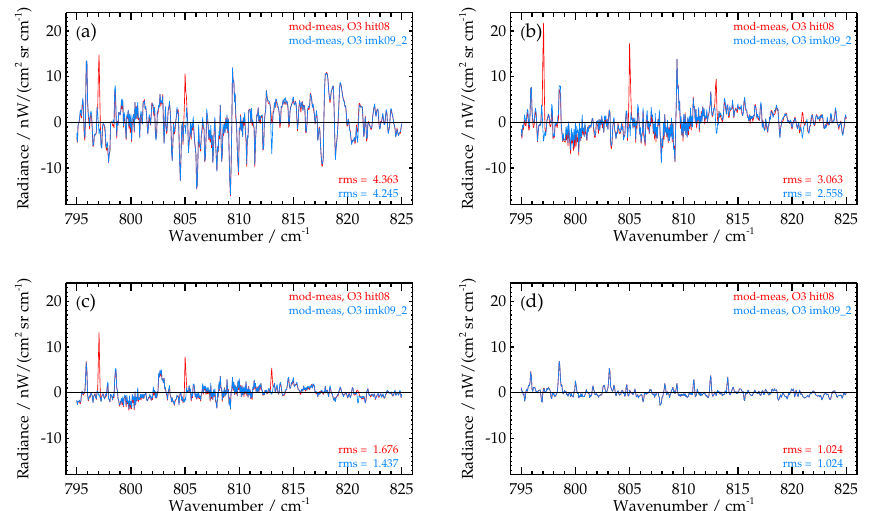
Figure 14. Residua between mean modelled and measured spectra using the HITRAN-2008 (red) and the MIPAS-pf3.2 ozone spectroscopy (blue) for tangent heights of (a) ∼ 14km, (b) ∼ 20km, (c) ∼ 30km and (d) ∼ 44km. Averaging over 302 (14km) and 442 spectra (higher altitudes) of 14 consecutive orbits (39680–39693) for the latitude range 30 ◦ S–30 ◦ N. The large red residua of the ozone lines at 797, 805 and 813cm − 1 are caused by inappropriate air-broadening coefficients in the HITRAN-2008 spectroscopy.